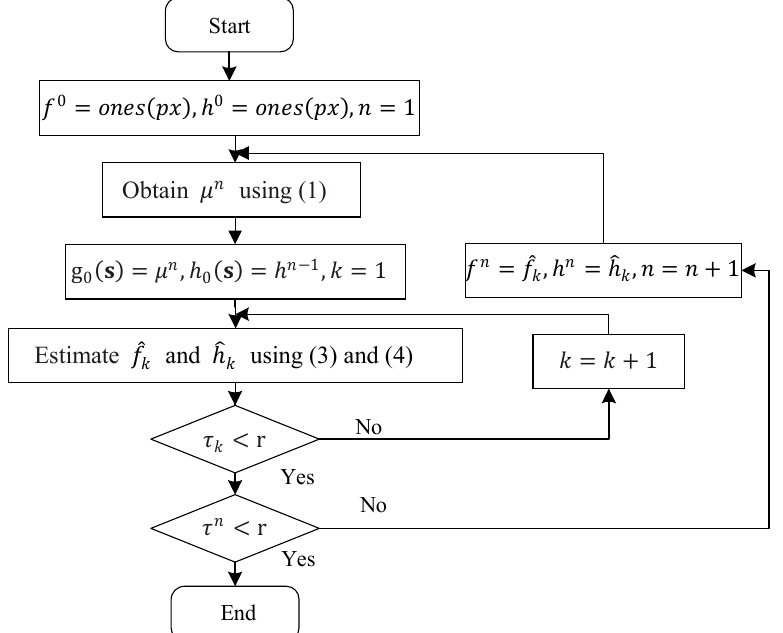
Figure 1. Flow chart of the combination of blind deconvolution and ordered subset expectation maximization reconstruction (BD-OSEM).